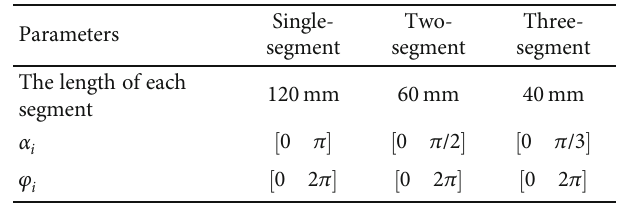
Figure 6: Changes of the robot ’ s fi nal position according to the mapping of the con fi guration space variables. Table 3: The simulation conditions for workspace.